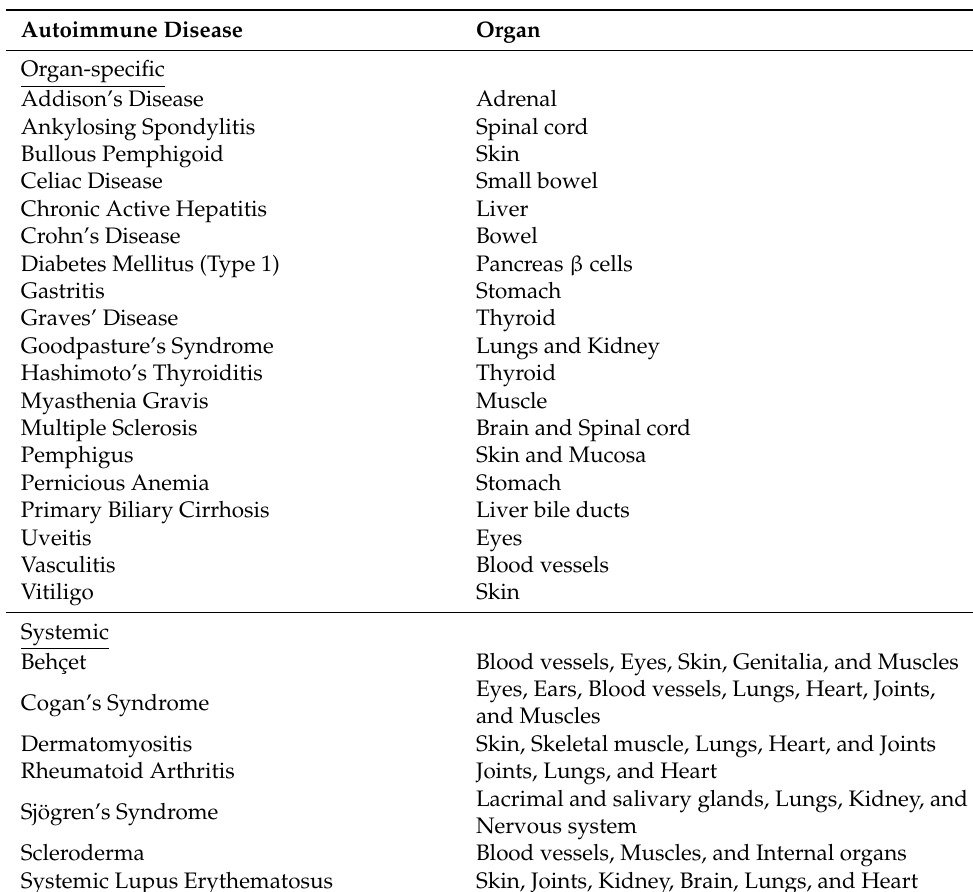
Table 1. Examples of organ-specific and systemic autoimmune diseases